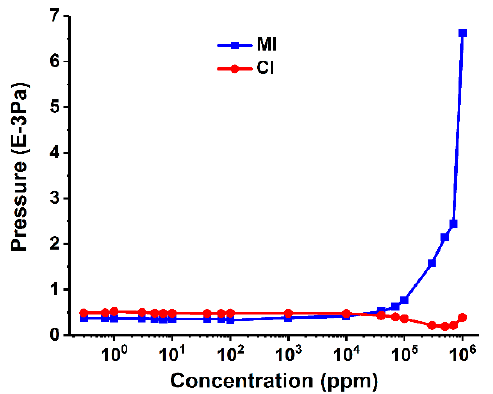
Figure 4. Variation of the chamber pressure with the sample concentration acquired in MI and CI experiments.